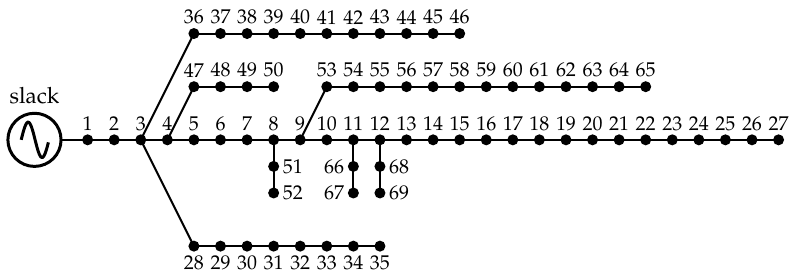
Figure 3. Electrical configuration of the 69-node test